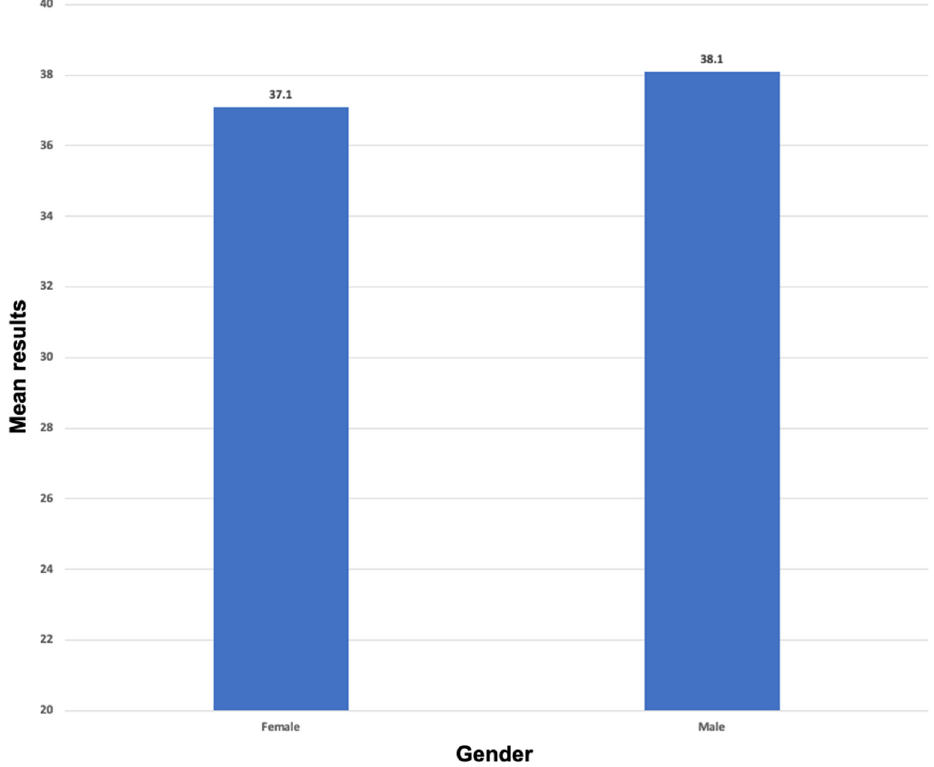
Figure 3. Mean results by gender.